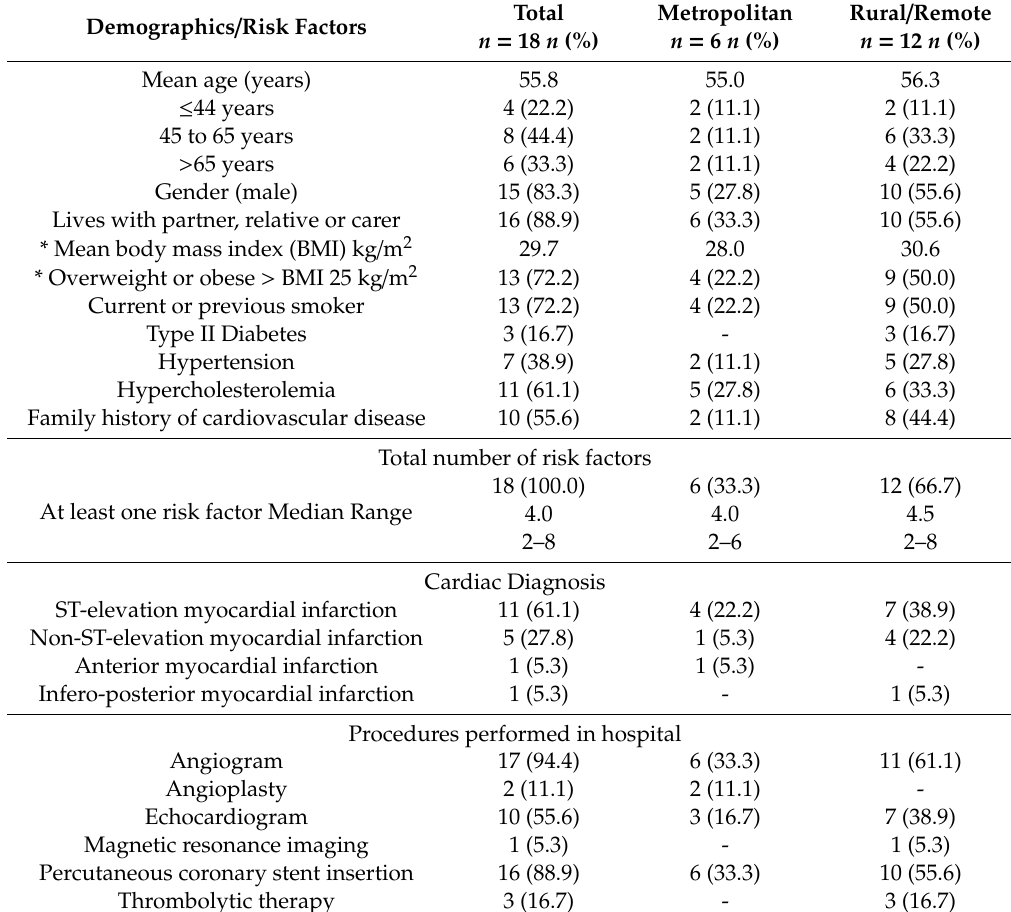
Table 2. Demographics, clinical characteristics and risk factors of